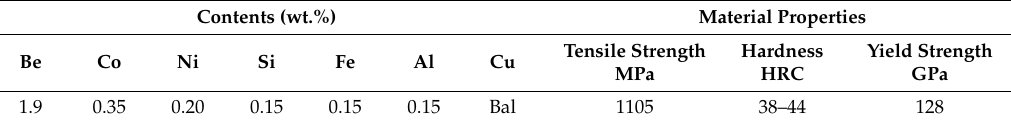
Figure 1. Machining center and test platform. Table 1. Chemical composition and mechanical properties of C17200.